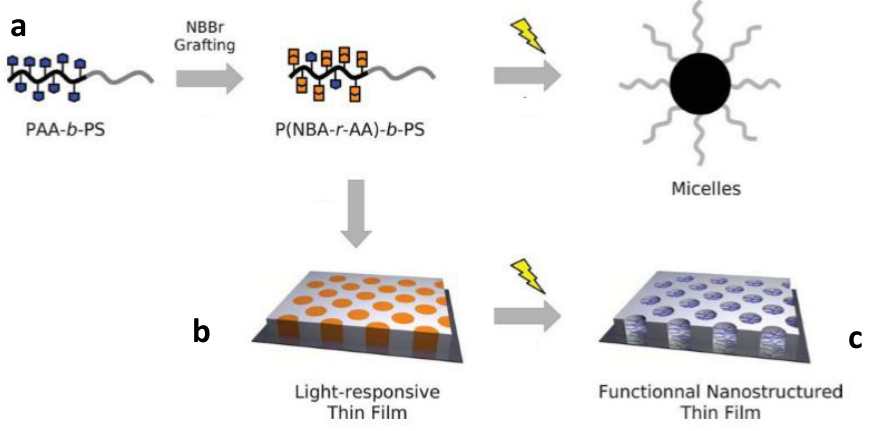
Figure 8. Schematic representation of light-responsive behavior of P(NBA-r-AA)-b-PS photocleavable block copolymers ( a ) light-induced micellization in a selective solvent of PS, ( b ) self-assembly in thin film with a cylindrical morphology, and ( c ) light exposure leading to functional and nanostructured thin films (Reprinted with permission from reference [93]).